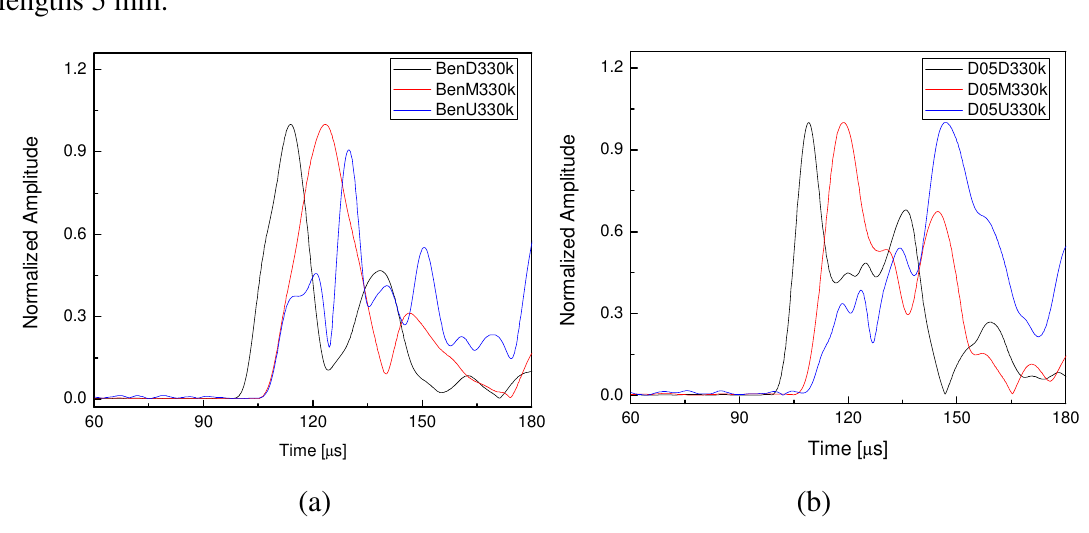
Figure 10. Normalized envelopes of guided wave signals measured by using He-Ne-based interferometer from (a) intact specimen and (b) defected specimen with debonding lengths 5